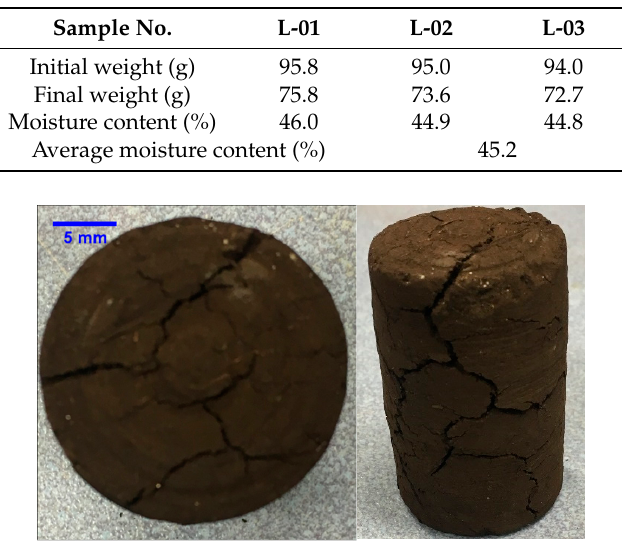
Figure 1. Fractures after low-temperature drying.